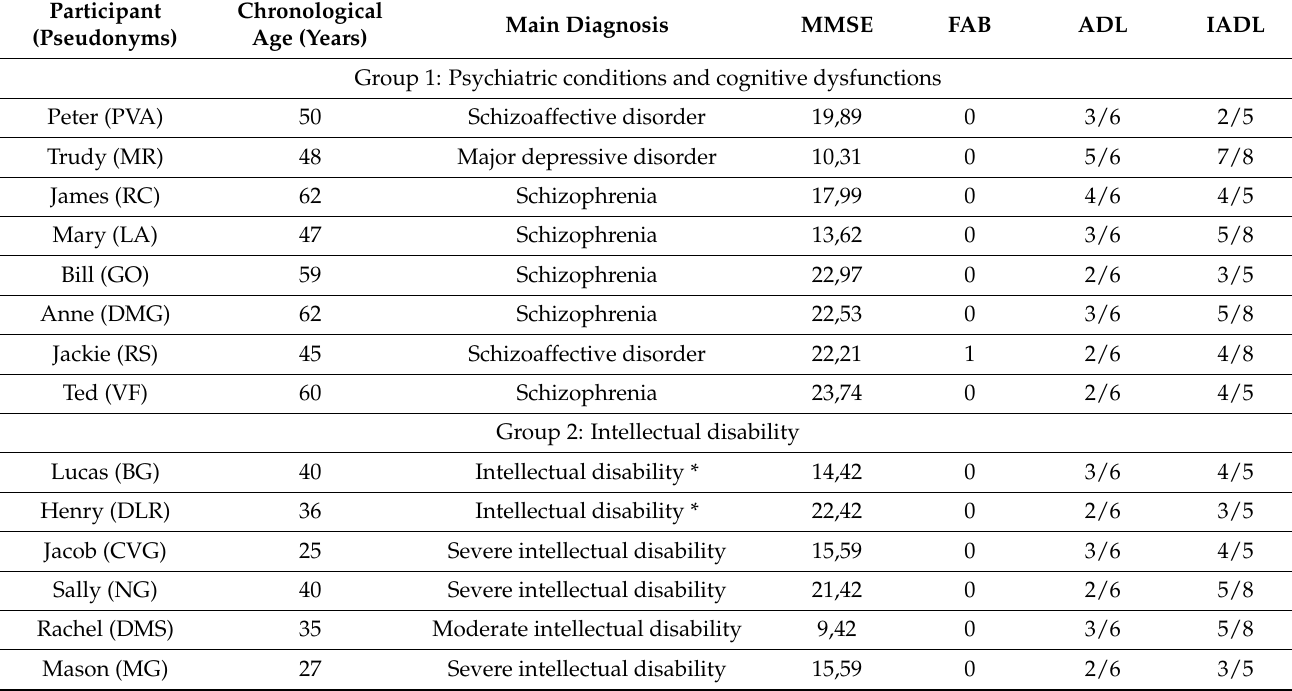
Table 1. Participants’ pseudonyms, chronological age, main diagnosis, and information on intellectual functioning (MMSE; FAB) and (instrumental) activities of daily living (ADL;